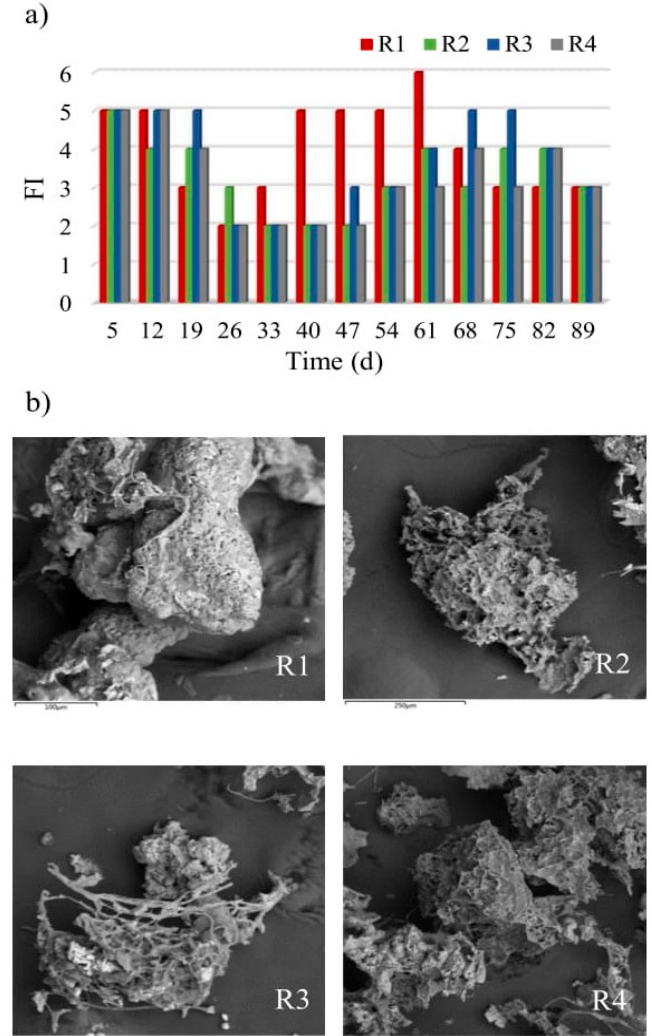
Figure 4. Changes in numbers of filamentous bacteria in reactors ( a ) and structure of granules resulting from their participation ( b ).